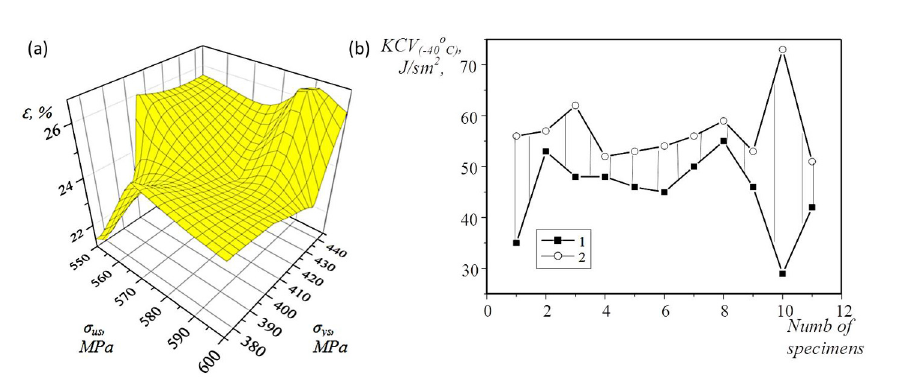
Figure 2. Initial mechanical properties (a) impact toughness of steel 17G1S (b) sets of pipes of pipeline ”Kiev-West of Ukraine 1” (initial state) according to certificate 162/3-69 1,2 - upper and lower limit lines.